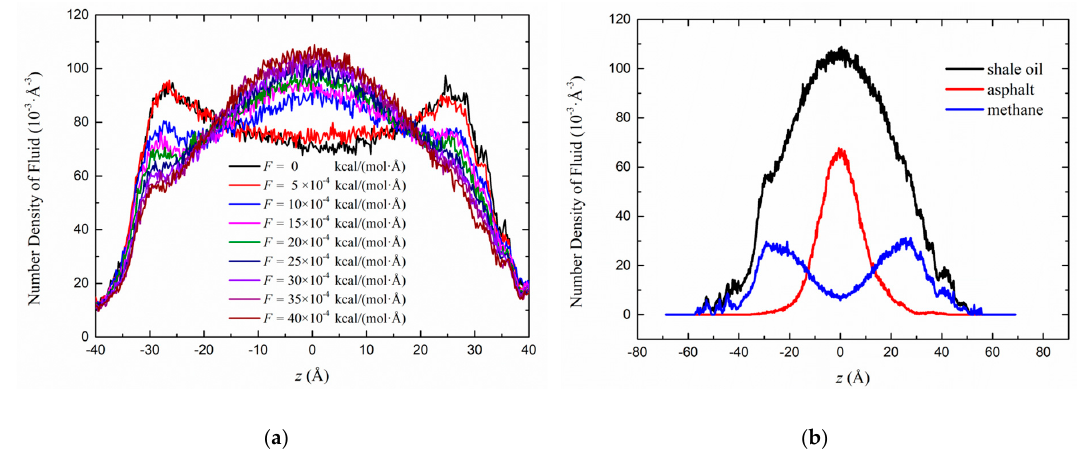
Figure 3. NEMD simulations: ( a ) The density profile of the fluid at different driving forces. ( b ) The density profile of the shale oil’s components assessed by the NEMD simulations. F = 40 × 10 − 4 kcal/(mol·Å). T = 300 K.